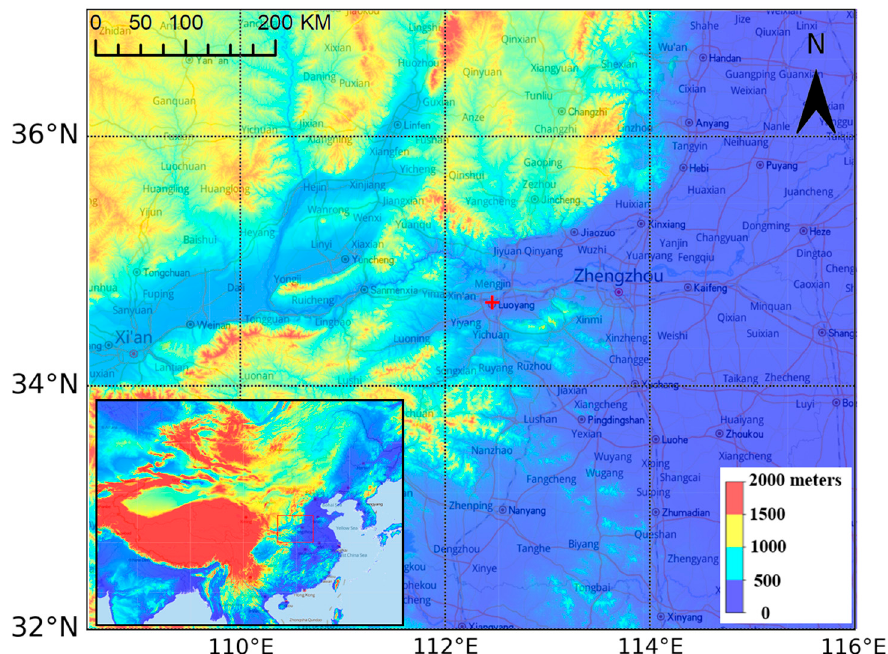
Figure 1. Study area topography and sampling location (red cross) (elevation data source: Jarvis